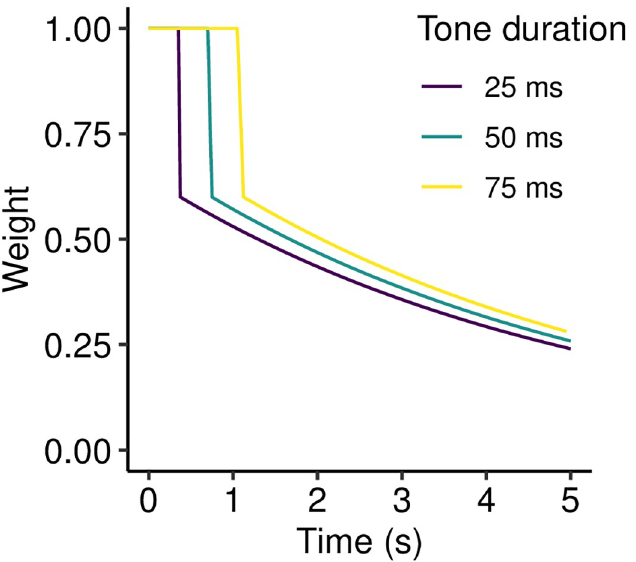
Fig 7. Decay kernels employed in Experiment 3. The temporal duration of the buffer corresponds to the buffer’s informational capacity (15 tones) multiplied by the tone duration.